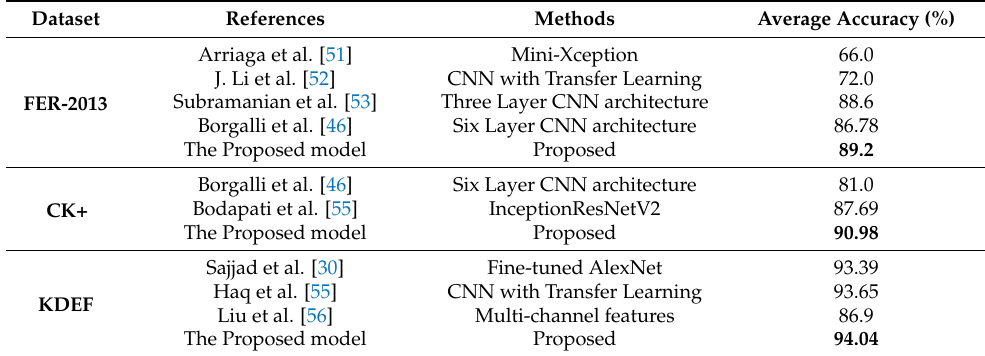
Table 9. Comparing the performance of the proposed model with the state-of-the-art method over three benchmark